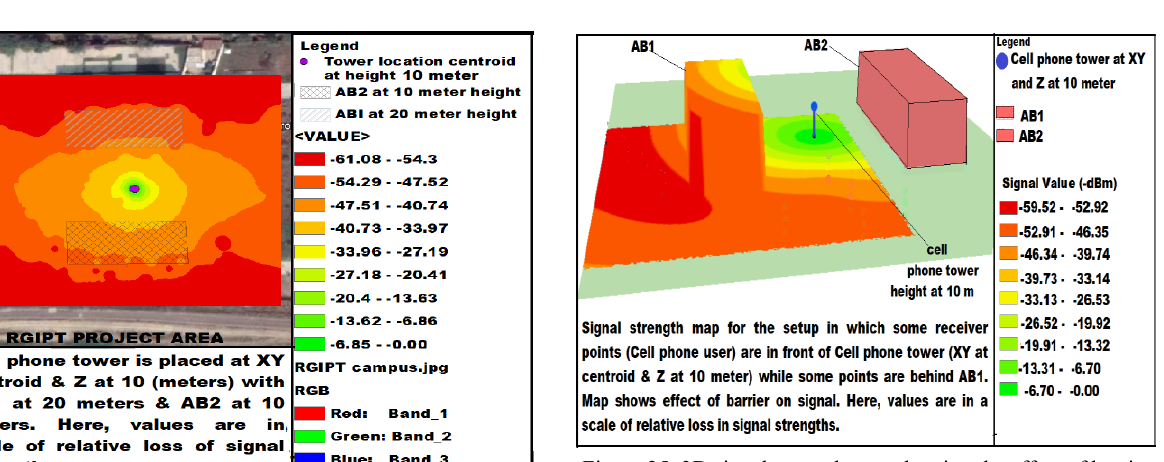
Figure 24. 3D signal strength map showing the effect of barrier on a signal when cell phone tower (XY at the centroid, Z at 0 meters).